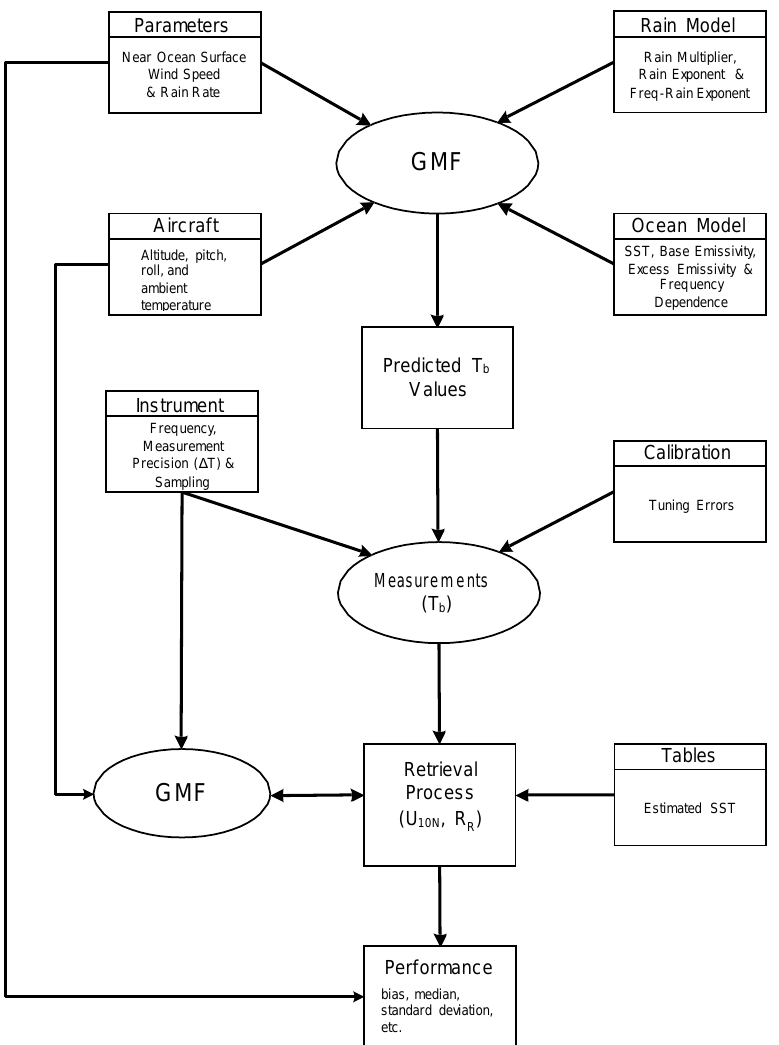
Figure 1. Block diagram for the Monte-Carlo simulation used to estimate the sensitivity to the calibration/tuning